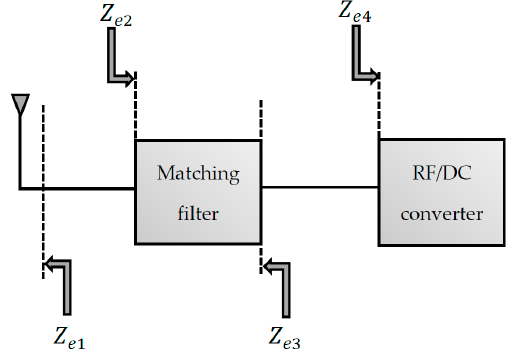
Figure 14. The principle of the impedance matching.